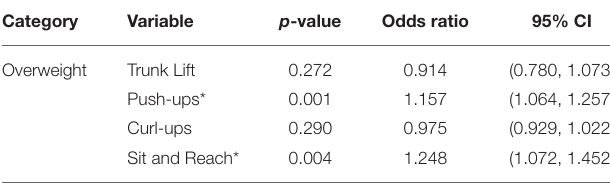
TABLE 10B | Associations between musculoskeletal fitness and weight status in kindergarten through fifth grades (reference group: obese). Category Variable p -value Odds ratio 95% CI Overweight Trunk Lift